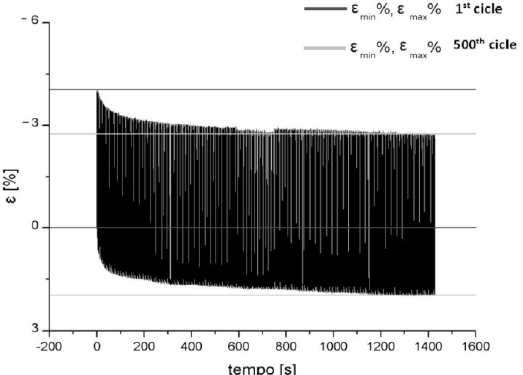
Figure 5: Thermal cycling under constant stress (250MPa). This process is performed to stabilize the SM properties of the